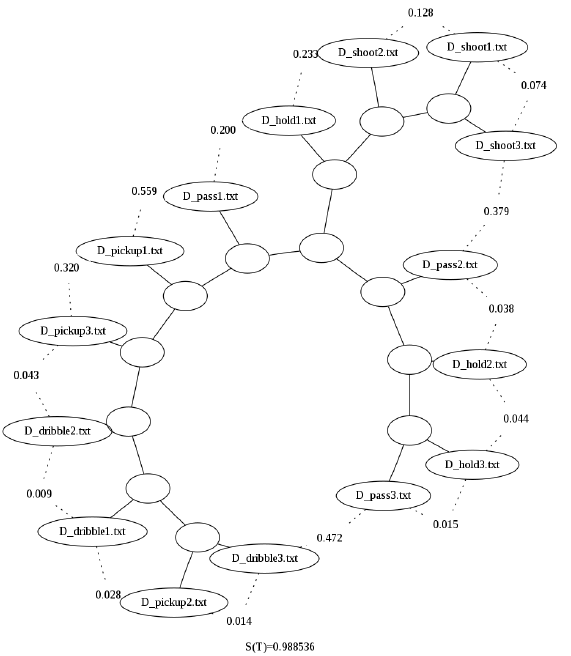
Figure 3. Binary tree generated using Zgli on the raw sizes of the Basketball data [29]. It can be seen that the shootings are the only type of data that is clustered together. Furthermore, the rest of the data is clustered